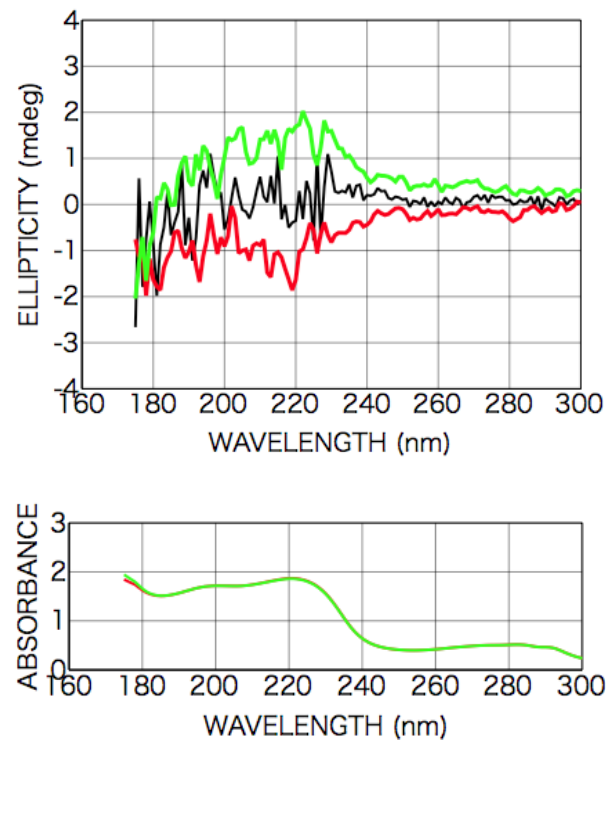
Figure 6. CD and photo absorption spectra of DL -tryptophan film before- (black) and after- (green and red) LPL irradiation. The sample rotation angle θ = 0 deg. (green) and θ = 90 deg.